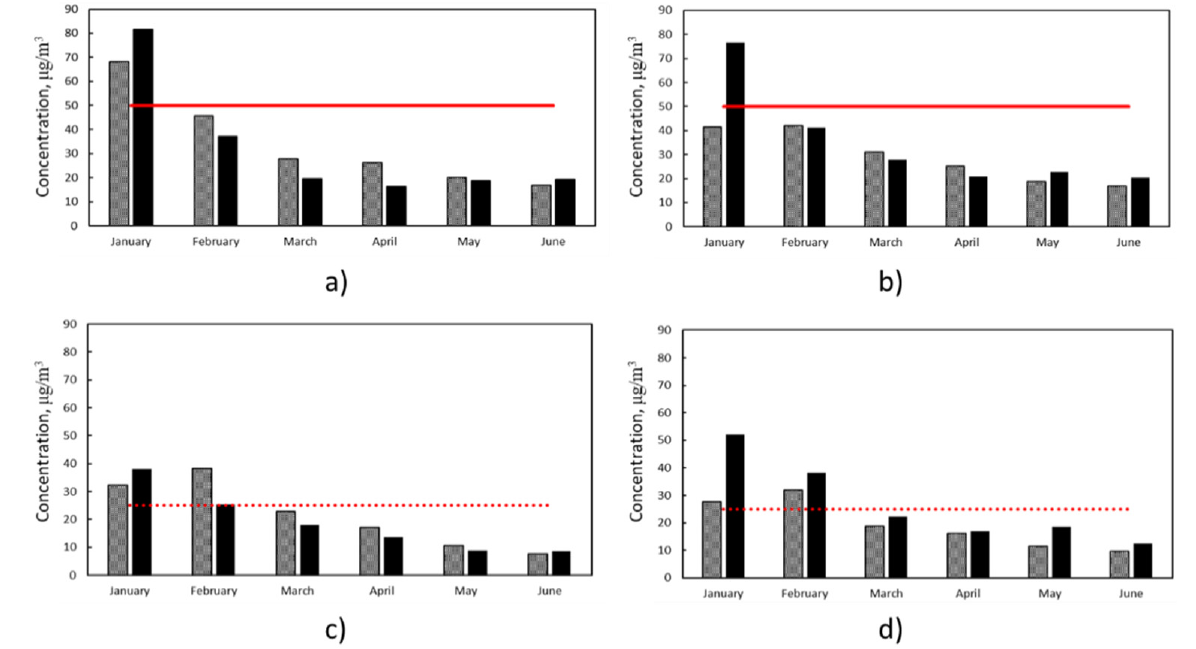
Figure 12. PM10 average monthly concentrations, measured by the ROM network (black) and the ARPALombardia (grey) in the months of January–April 2020 in Milan. Data for ARPA were taken from a single station, while data for the ROM network were taken by averaging all the data coming from all the cells within the same NIL, in which the ARPA station is located. The red solid line and the red dotted lines are the PM10 and PM2.5 daily law limits, according Lgs 155/2010, respectively. ( a ) PM10 monthly averages, relevant to the VE station; ( b ) PM10 monthly averages, relevant to the VP station; ( c ) PM2.5 monthly averages, relevant to the VE station; ( d ) PM2.5 monthly averages, relevant to the VP station.